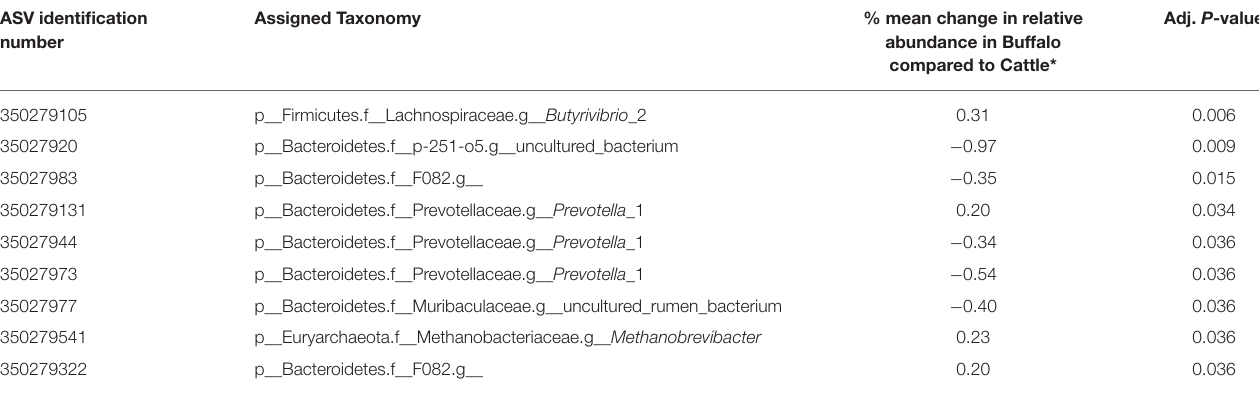
TABLE 3 | The effect of host type on ASVs was compared using an unpaired Wilcoxon test with data normalized using relative abundance and P values adjusted using the Benjamini–Hochberg procedure to decrease the false discovery rate. ASV identification Assigned Taxonomy % mean change in relative number